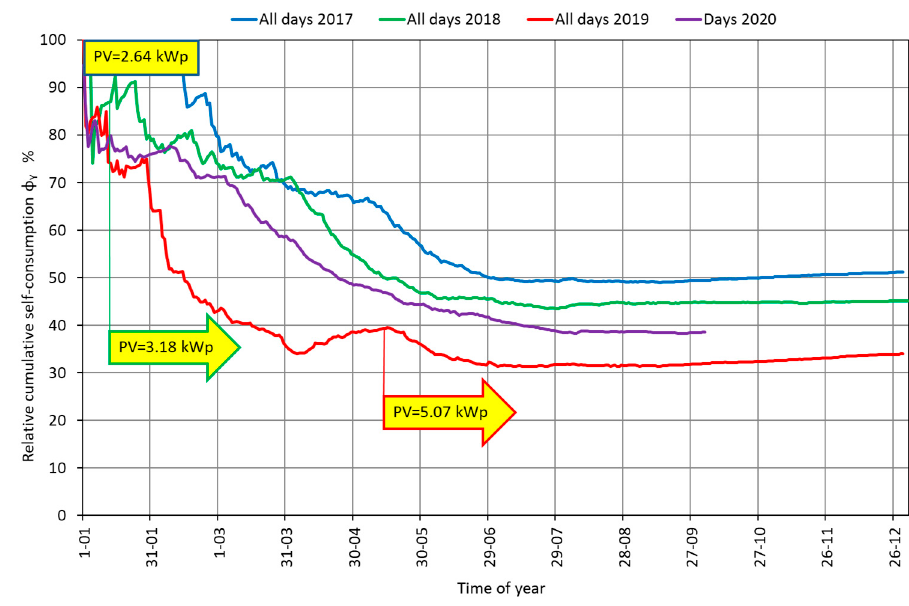
Figure 15. Cumulative self-consumption average in a period of one year for the 3 next years.